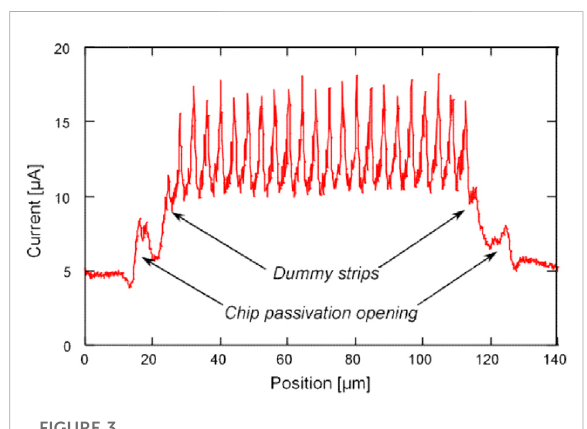
FIGURE 3 Signal from a set of microstrip 1.5 μ m wide and spaced by 3.5 μ m. Measurement was performed with an electron beam, bias voltage the detector was 30 V and beam energy was 20